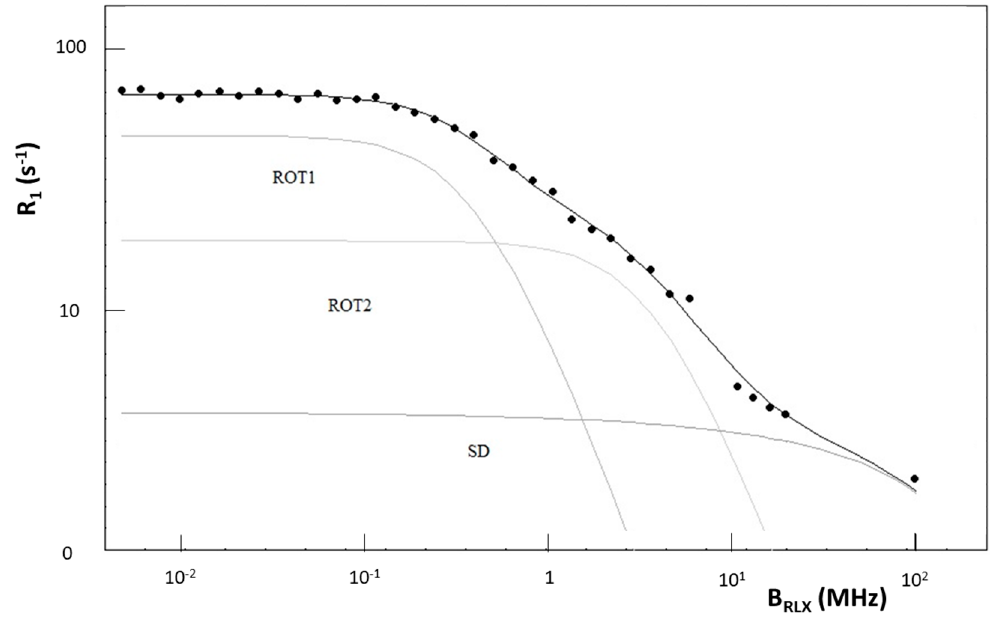
Figure 8. Frequency (MHz) dependence of proton spin-lattice relaxation rate, R 1 (s − 1 ) of L1 at T = 396 K, in a Logarithmic scale, recorded in the high-temperature isotropic phase. The black curve represents the best fitting curve of the R 1 -dispersion by using Equation (4) with two rotational processes ( ROT1 and ROT2 ) described by the BBP model (Equation (5)) and the self-diffusion (SD) process (Equation (6)). Fitting data are reported in Table 2.